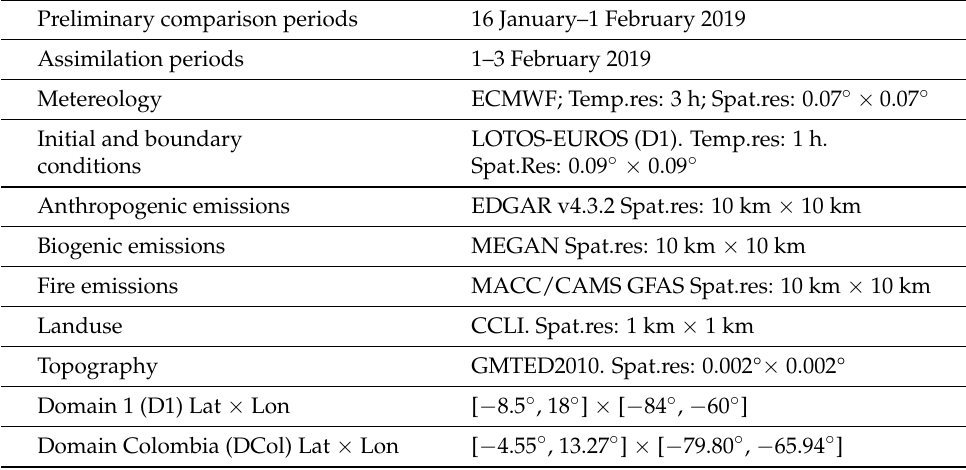
Table 1. LOTOS-EUROS configuration settings for the simulations performed in this